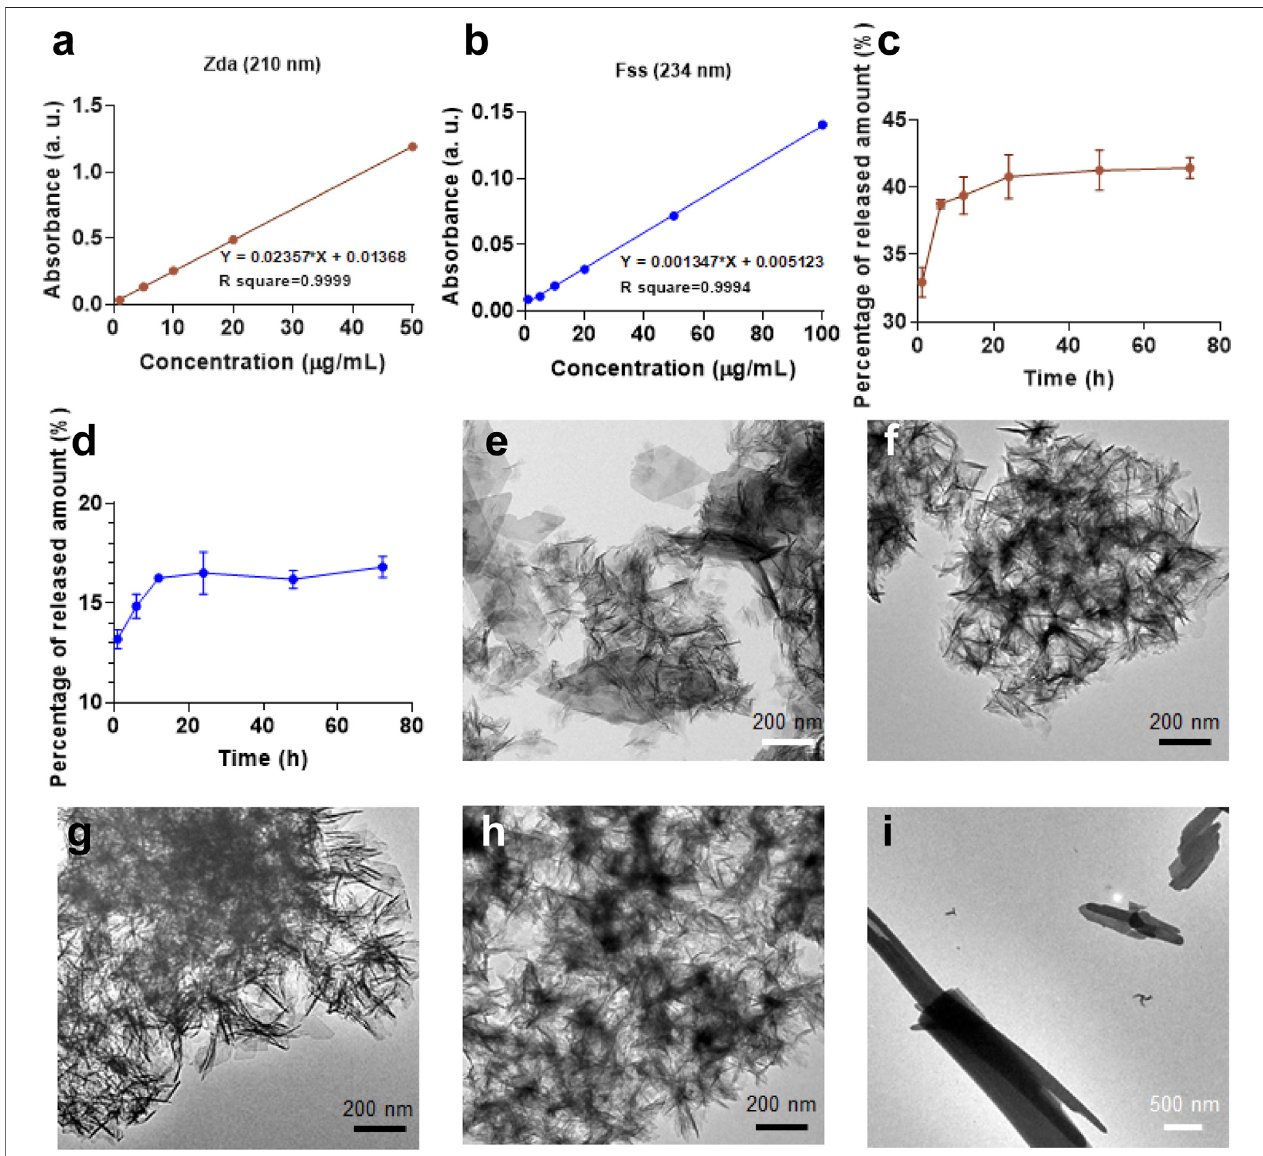
FIGURE 5 | Absorbance-concentration curve of (A) Zda and (B) Fss obtained from related UV-Vis absorption curves in Supplementary Figure S5A,B ; (C) Zda- release and (D) Fss-release curves of CaP/Zda and CaP/Fss in PBS. TEM micrographs of (E) CaP Control — 72 h, (F) CaP/Adn — 72 h, (G) CaP/Cpp — 72 h, (H) CaP/ Zda — 72 h, and (I) CaP/Fss — 72